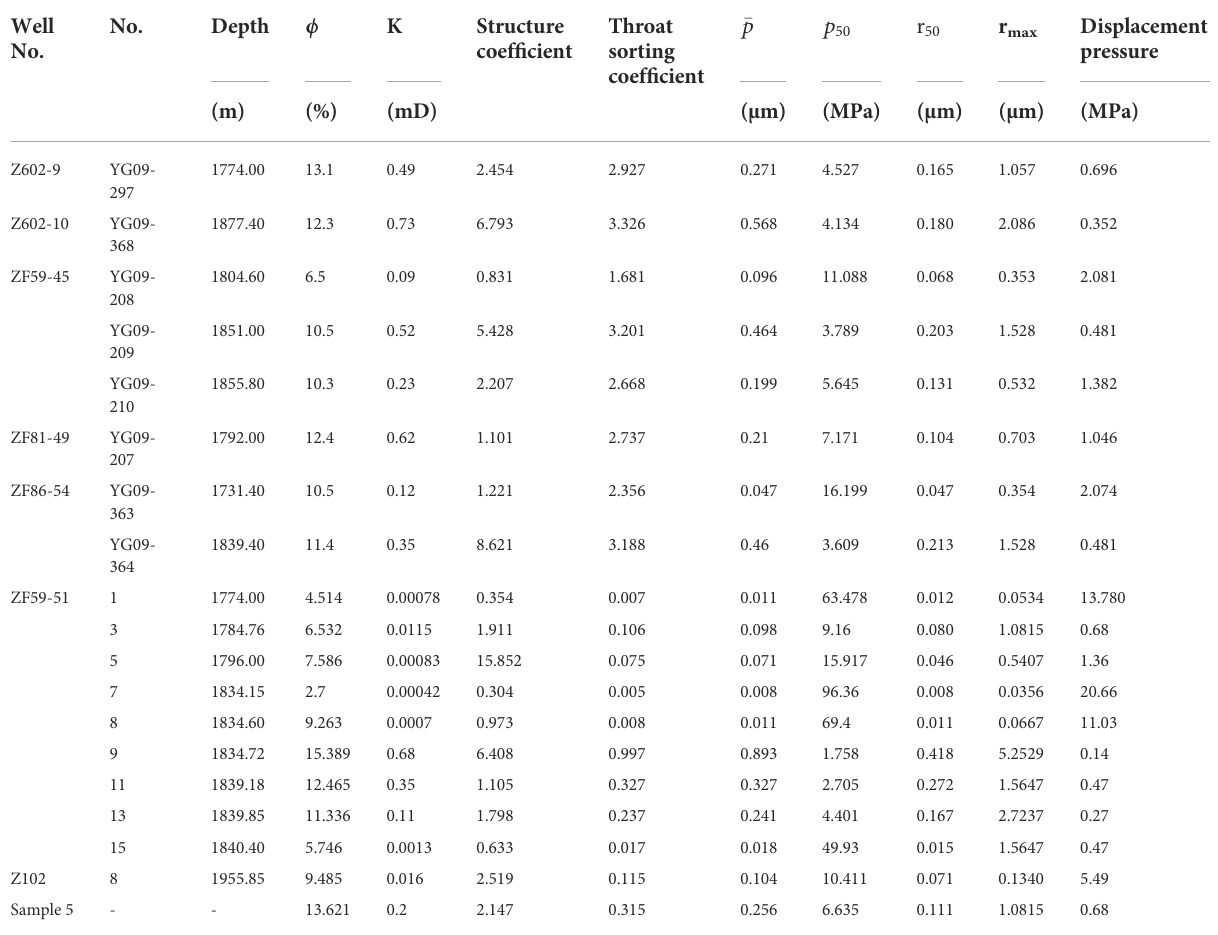
TABLE 1 The basic information about the cores. Well